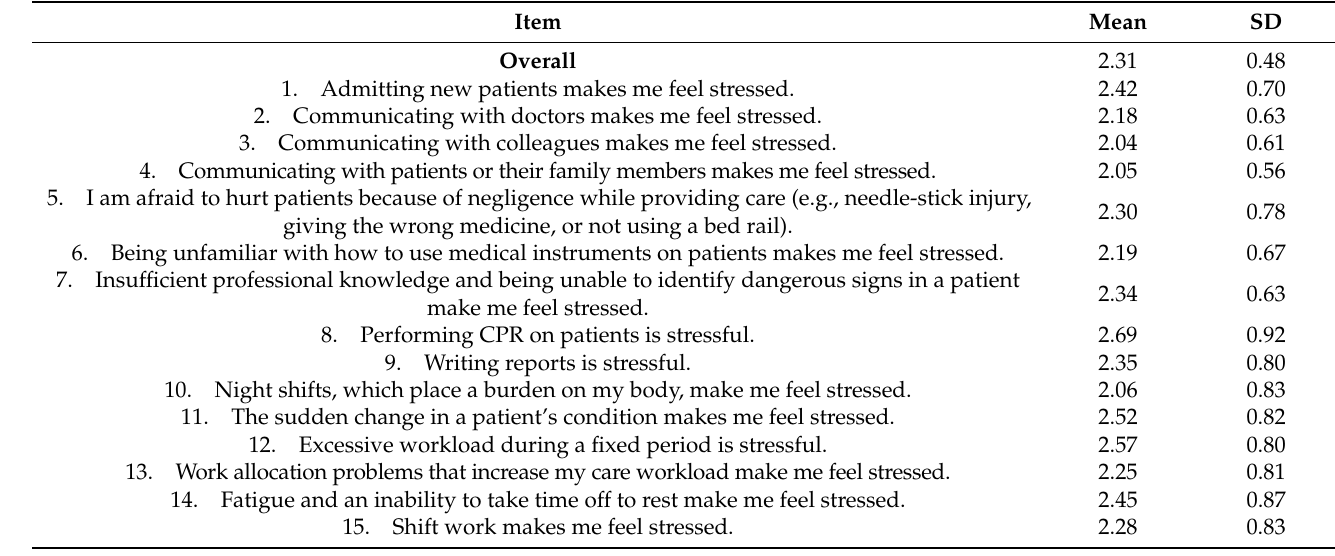
Table 3. Clinical stress scale results (N =